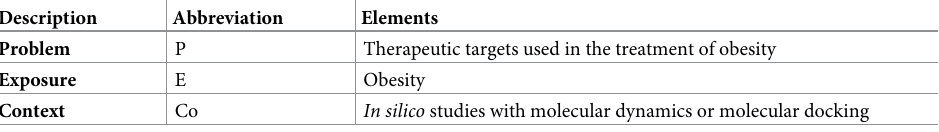
In silico studies with molecular dynamics or molecular docking PECo (P, problem; E, exposure; Co, context).